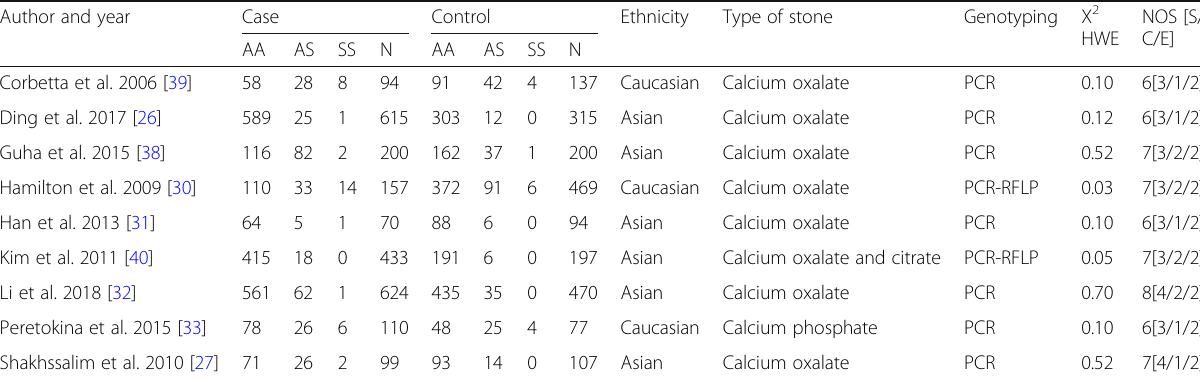
Table 2 Baseline characteristics of studies concerning CaSR A986S gene polymorphism in patients with urolithiasis included in the